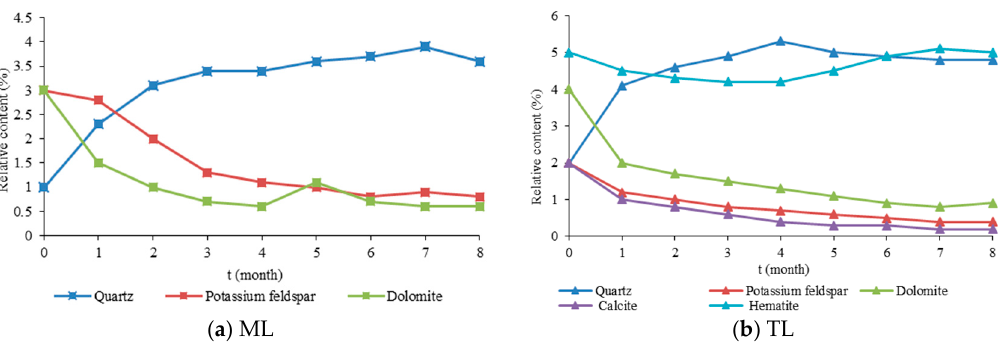
Figure 4. Variations of mineral contents with time: ( a ) ML and ( b ) TL.